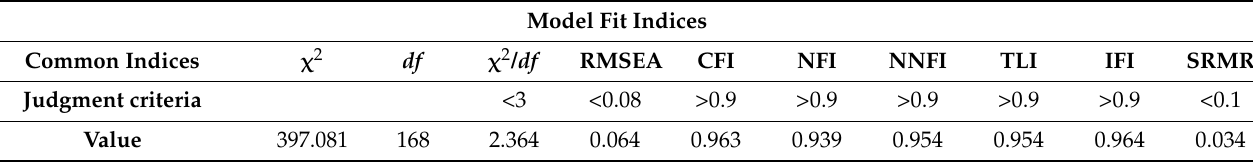
Table 6. Model fit